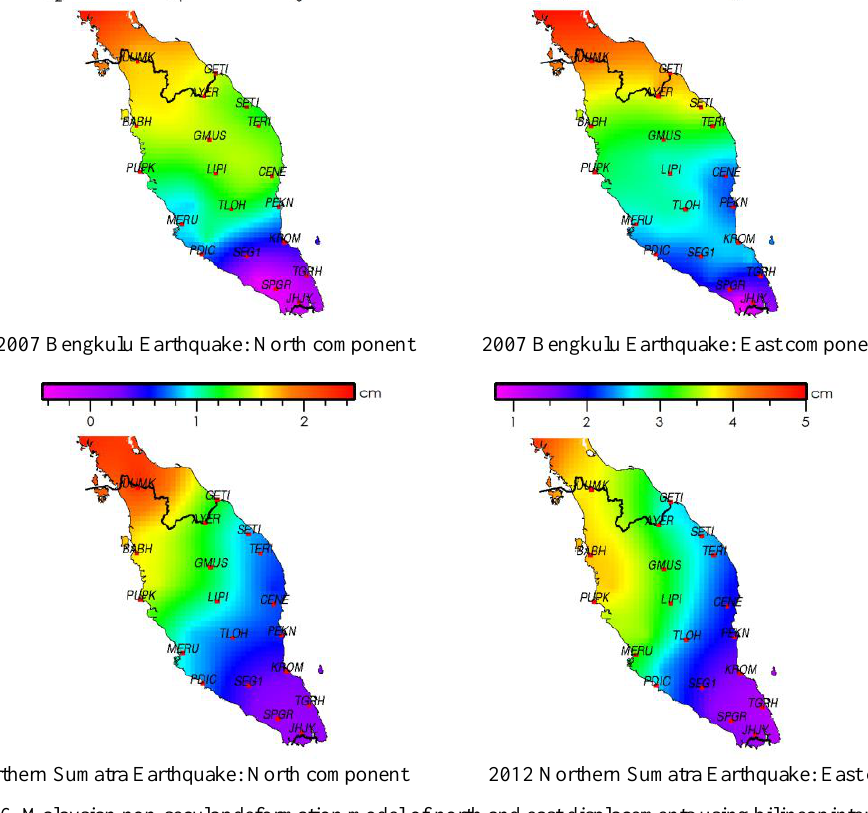
Figure 6. Malaysian non-secular deformation model of north and east displacements using bilinear